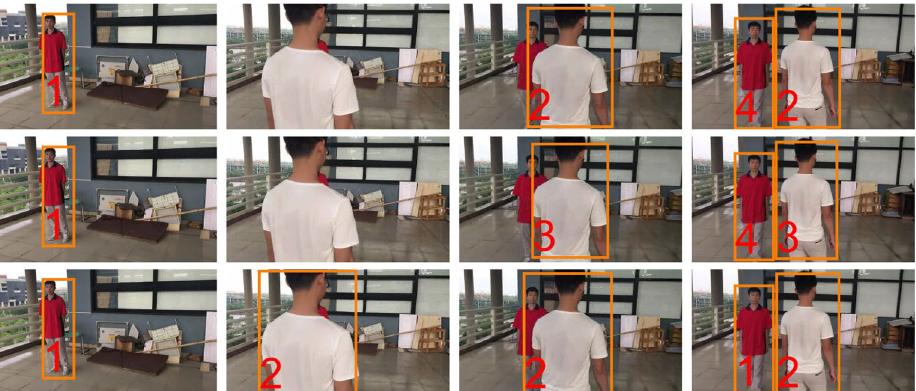
Figure 5. Intra-camera tracking comparison (proposed dataset: scene 2 and camera 2) with target-size changes and one heavy occlusion. Top to bottom: DeepSORT 29 , MDP 27 and DMMA-nc. Left to right: frames 1, 190, 203 and 220. DeepSORT and MDP wrongly assign labels 3–4.